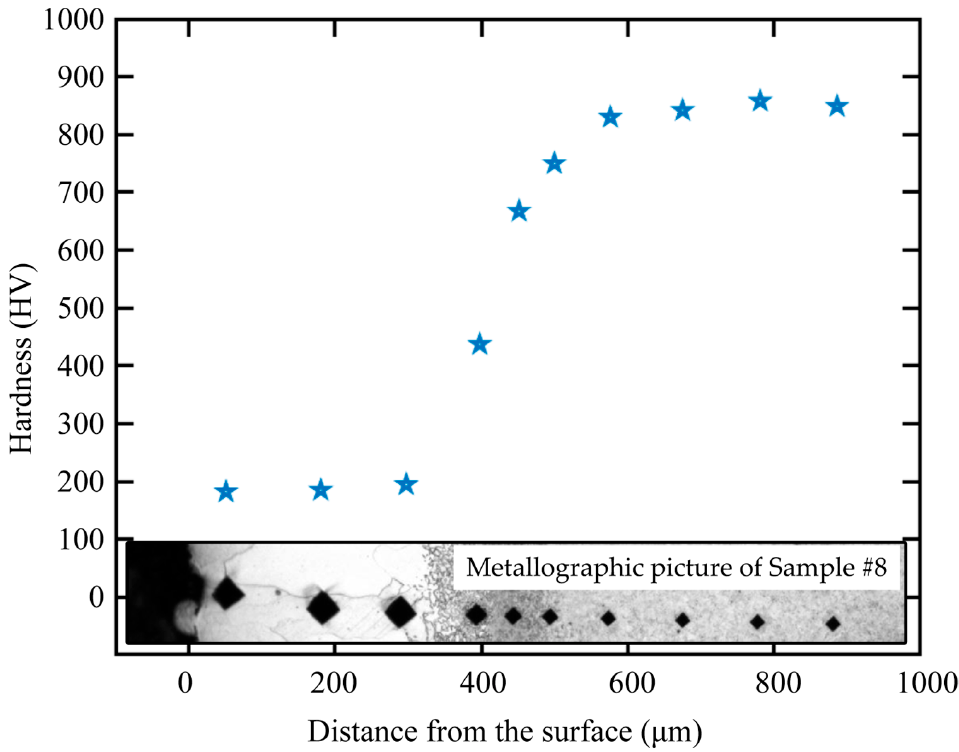
Figure 4. Hardness profiles and metallographic picture of the steel sample with a martensitic core austenitized for 6 h (Sample 8#).